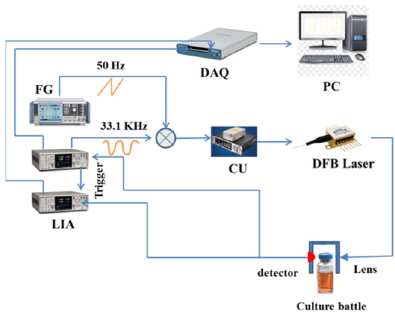
Figure 1. Schematic diagram of optical detection system based on DLWMS technology.